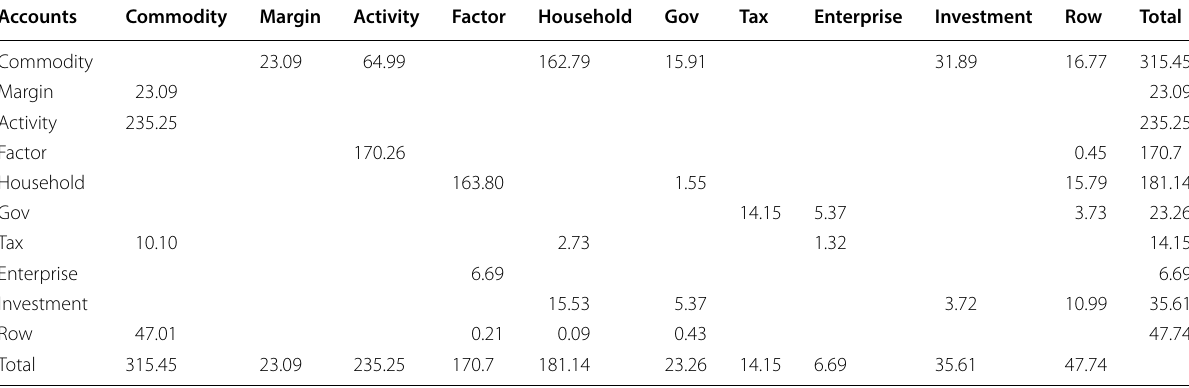
Table 1 Macro SAM of Ethiopia (in billions Ethiopian